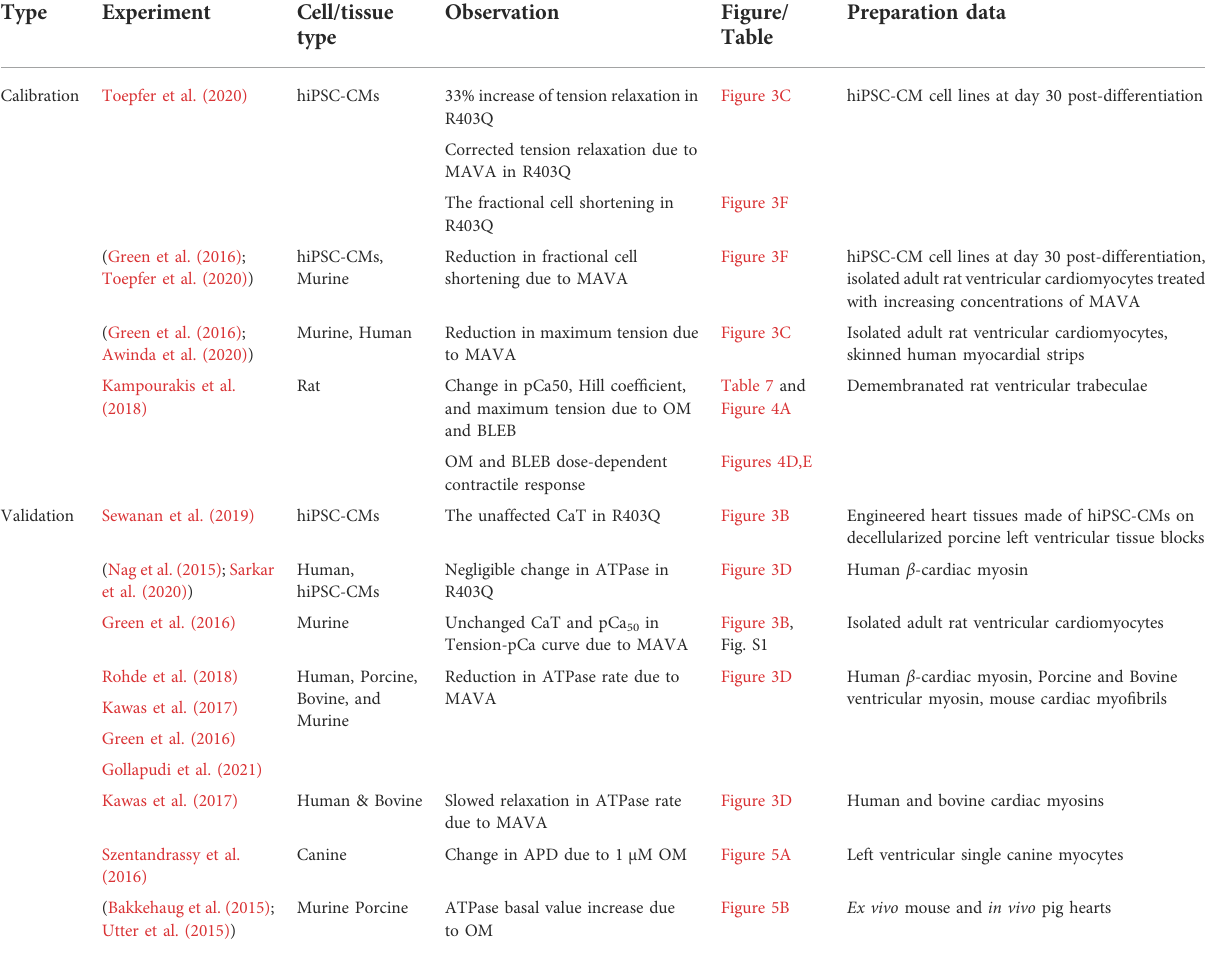
TABLE 5 The experimental data used for calibration of the model and validation of the simulated results.